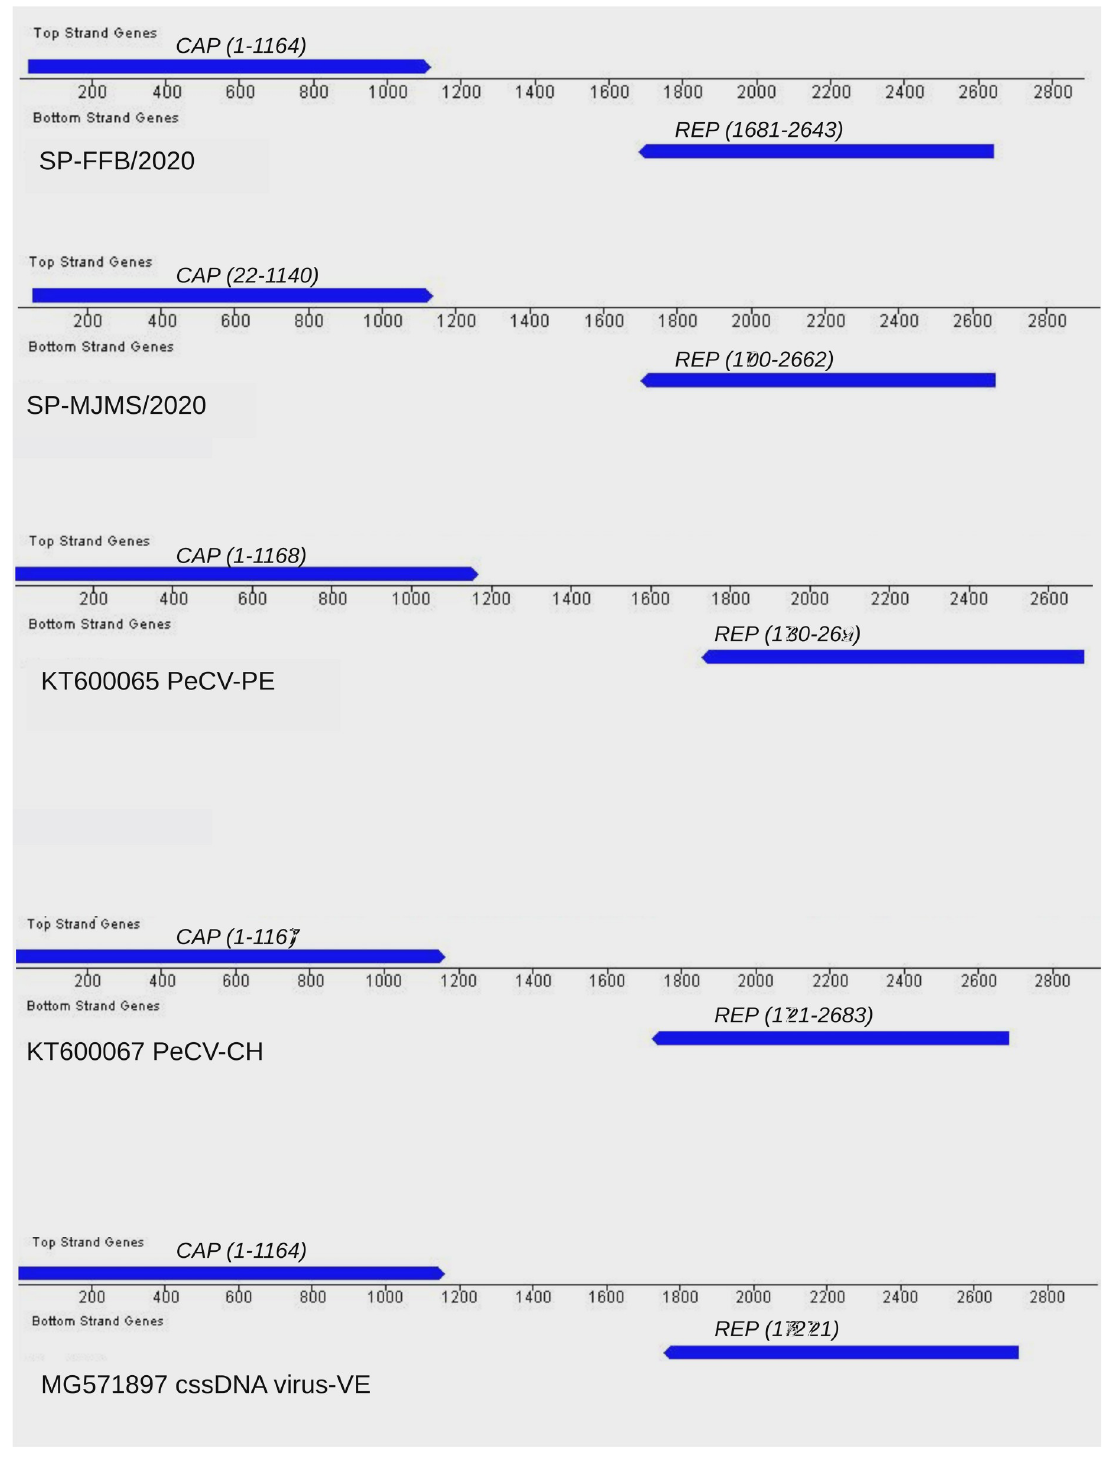
Fig 1. Annotated genomes of PeCV. Each diagram represents the annotation of one sequence. Lines represent genome position and blue are indicating ORFs CAP and REP in opposite orientation. Numbers within parenthesis indicate the location of ORFs in each sequence. Diagrams were constructed with Gatu